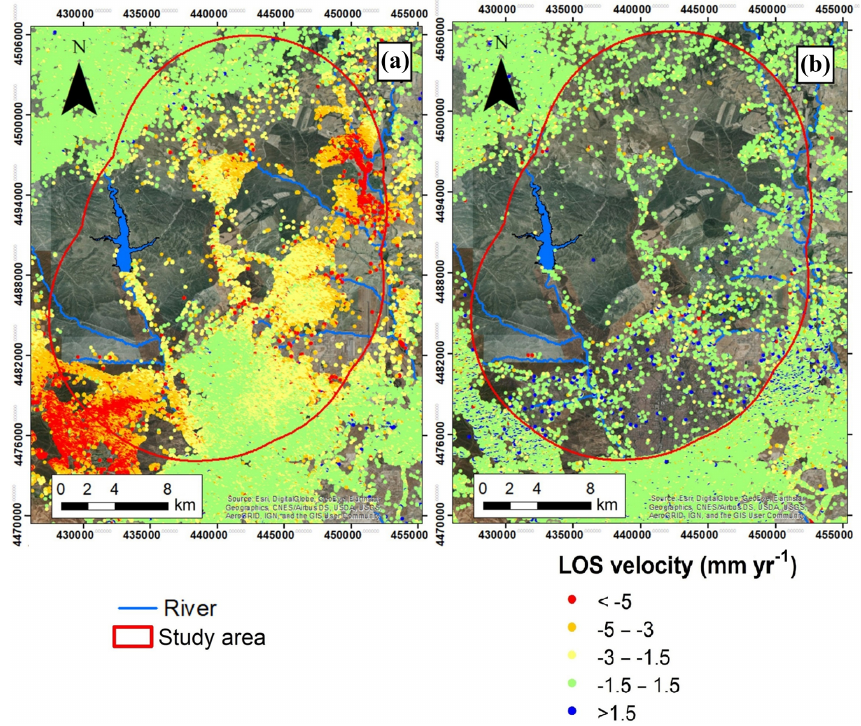
Figure 2. Line-of-sight (LOS) velocity maps measured usingERS-1/2 (1992–2000) (a) and ENVISAT (2003–2010) images (b) . World imagery Source: Esri, DigitalGlobe, GeoEye, Earthstar Geographics, CNES/Airbus DS, USDA, USGS, AeroGRID, IGN, and the GIS User Community.